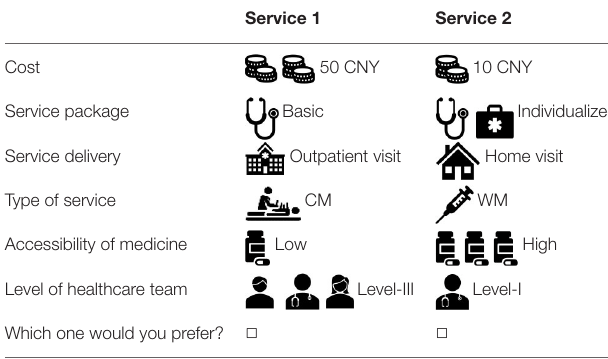
TABLE 2 | Example of a DCE choice